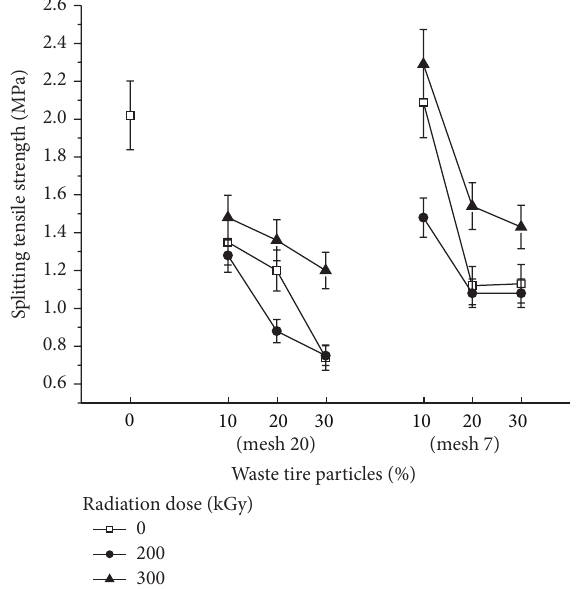
Figure 3: Splitting tensile strength of concrete with waste tire particles of 0.85 mm (mesh 20) and 2.8 mm (mesh